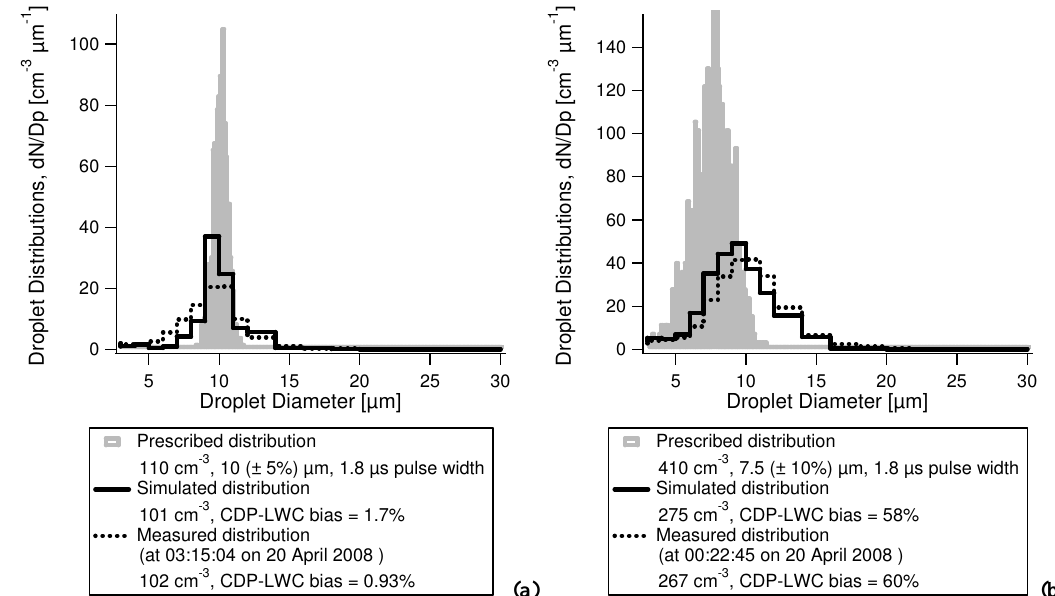
Fig. 14. Prescribed and simulated droplet size distributions at droplet concentrations of (a) 110cm − 3 and (b) 410cm − 3 . The simulated CDP-LWC bias for each of these cases is consistent with the range of CDP-LWC biases observed at a given droplet concentration during the ARCPAC flights. Also shown for comparison are 1Hz droplet size distributions at comparable droplet concentrations, as measured during the 19 April 2008 flight.